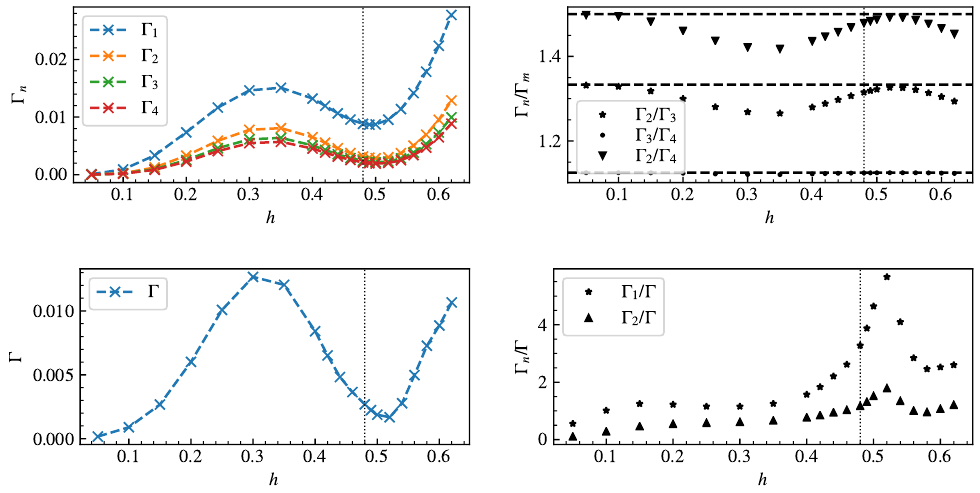
Figure 4.2: Left panels: Entropy growth rates Γ (top) and magnetisation relaxation n rate Γ (bottom) for longitudinal quenches in the quantum Potts spin chain starting from g = 1.75 as a function of the longitudinal coupling, in units with J = 1. Right: / Γ / Γ (bottom). The dashed lines represent the universal ratios Ratios Γ (top) and Γ n m n (4.4) that are restored in the limit h → 0. The vertical line is drawn at the value h where the second quasi-particle appears in the post-quench